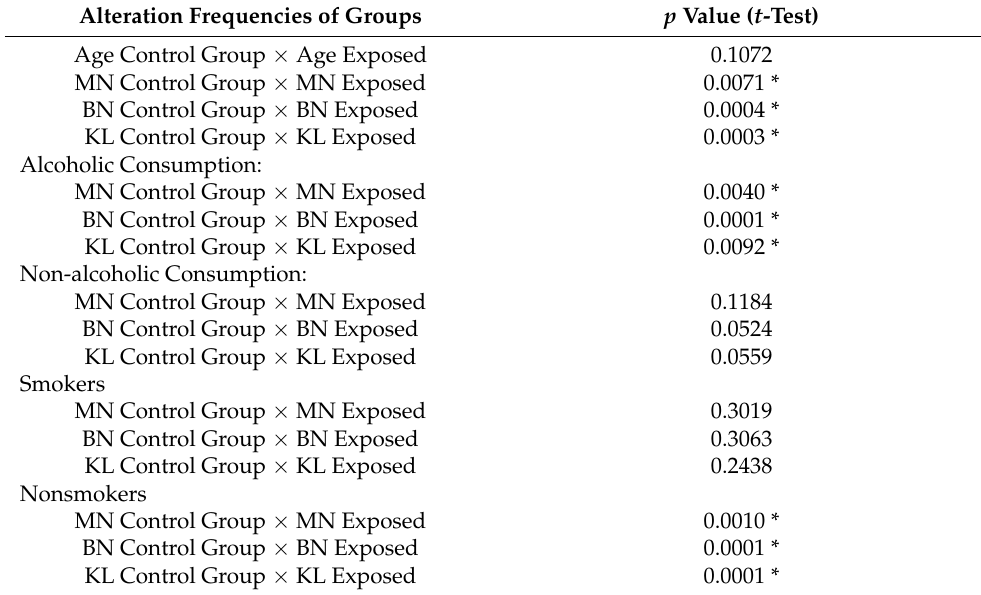
Table 2. Influence of age, alcohol consumption, and smoking on the genotoxicity biomarkers